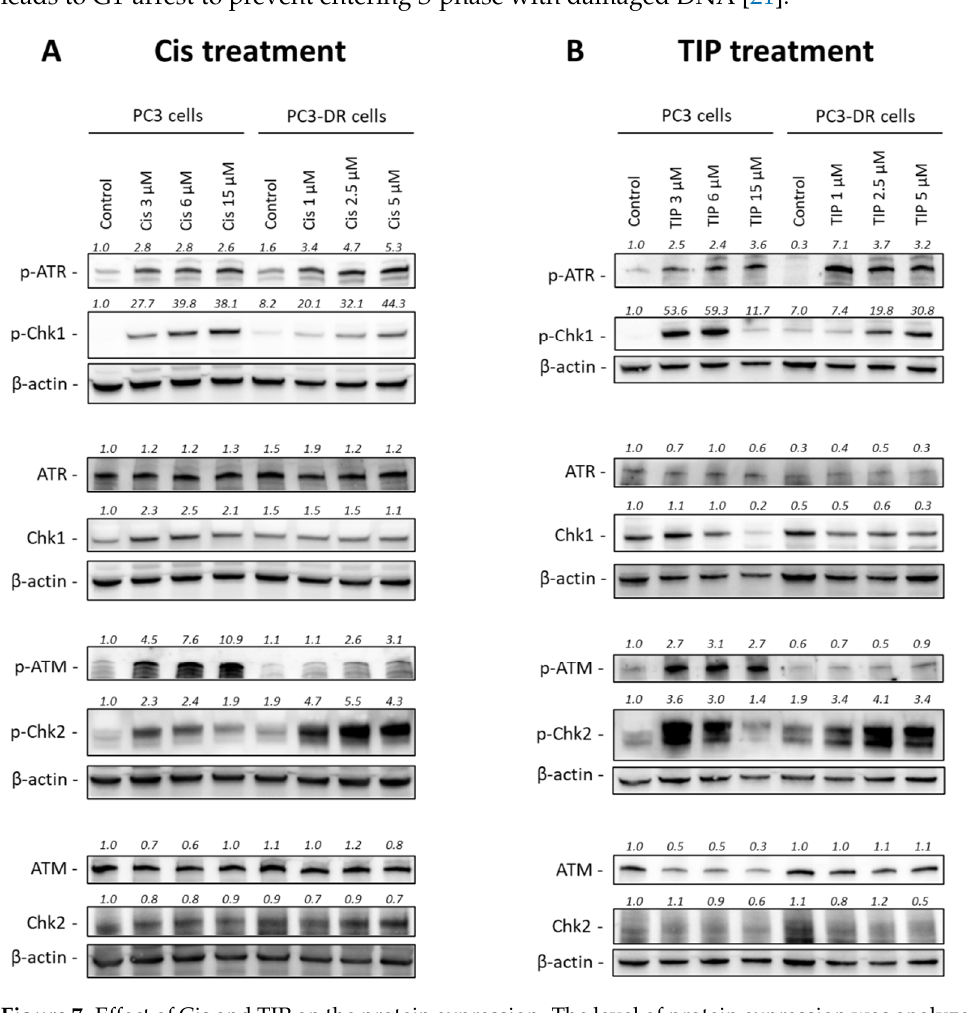
Figure 7. Effect of Cis and TIP on the protein expression. The level of protein expression was analyzed by Western blotting. PC3 or PC3-DR cells were treated with indicated concentrations of Cis ( A ) or TIP ( B ) for 48 h. For TIP treatment the following drug concentrations were used: for PC3 cells TIP 3 (Cis 3 µM, Ifo 2 mM, Pac 30 nM), TIP 6 (Cis 6 µM, Ifo 4 mM, Pac 60 nM), TIP 15 (Cis 15 µM, Ifo 10 mM, Pac 150 nM); for PC3-DR cells TIP 0.5 (Cis 0.5 µM, Ifo 2 mM, Pac 50 nM), TIP 1 (Cis 1 µM, Ifo 4 mM, Pac 100 nM), TIP 2.5 (Cis 2.5 µM, Ifo 10 mM, Pac 250 nM).